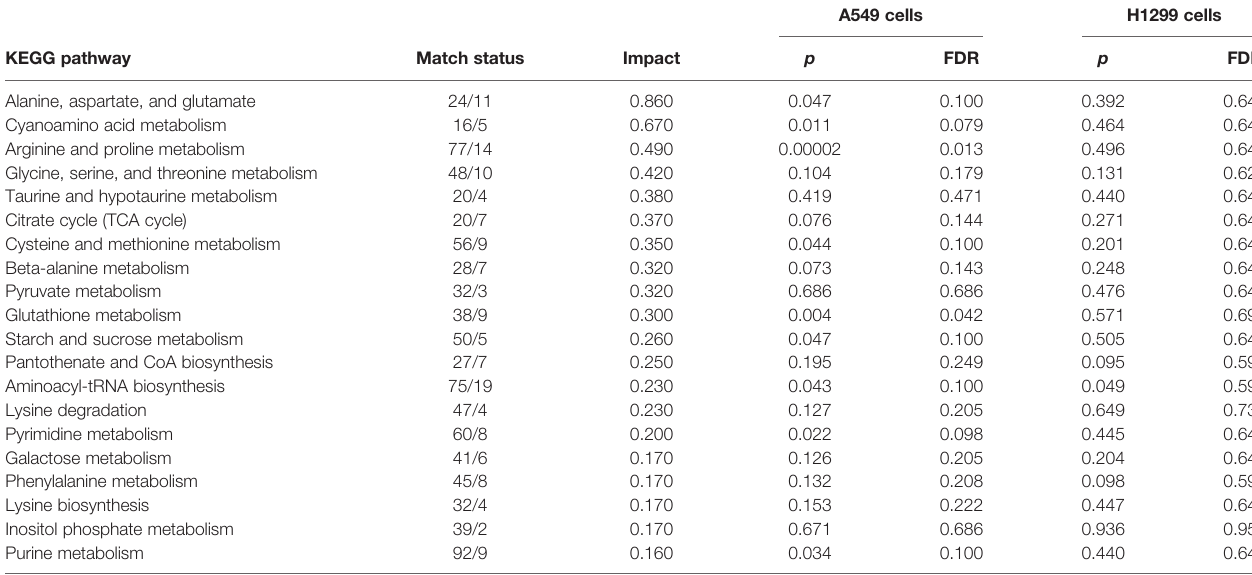
A549 cells H1299 cells